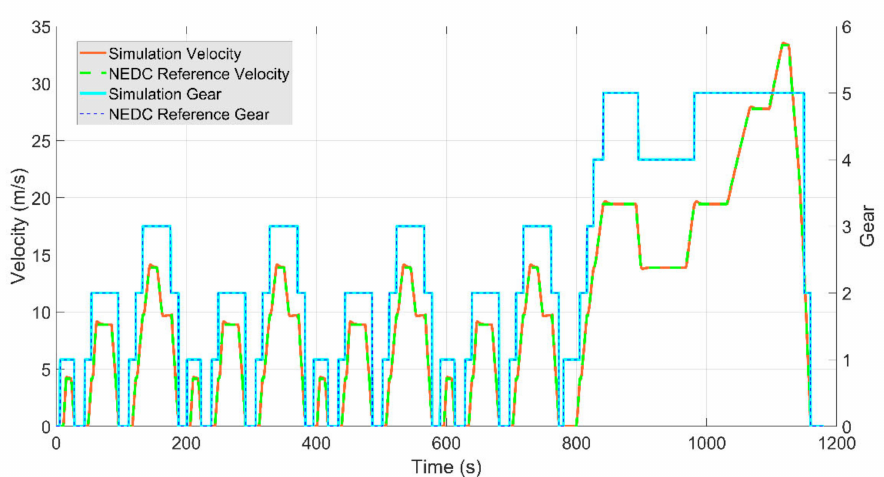
Figure 5. Speed profile and actual gear in